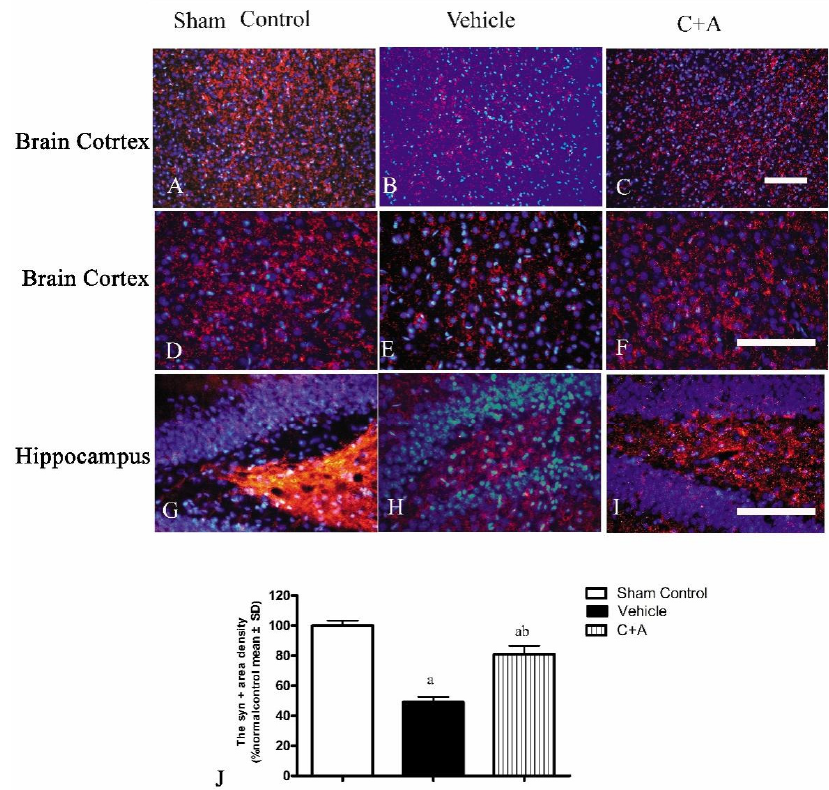
Figure 9. ( A – I ): Immunofluorescence staining (red) of Syn in the motor cortex ( A – F ) and hippocampus ( G – I ). The nuclei of neurons in the cortex and hippocampus were visualized by Hoechst 33342 staining (blue). ( J ): Quantification of Syn-positive areas showed that treatment with C16 plus Ang-1 induced the expression of Syn in AD rats. Scale bar = 100 µm. a, p < 0.05 vs. sham control group; b, p < 0.05 vs. vehicle group.